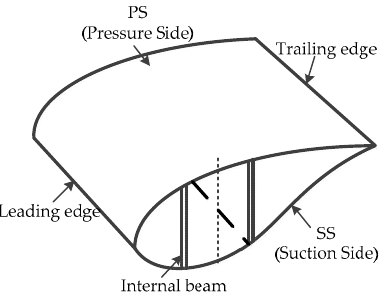
Figure 3. The structure of a wind turbine blade.